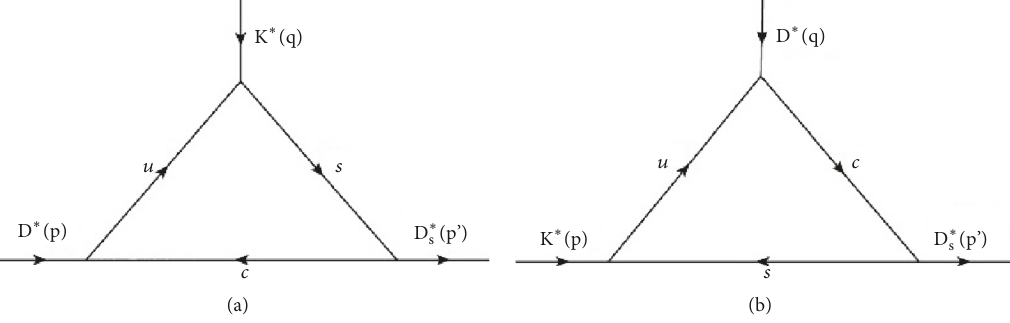
Figure 1: Perturbative diagrams for off-shell 𝐾 ∗ (a) and off-shell 𝐷 ∗